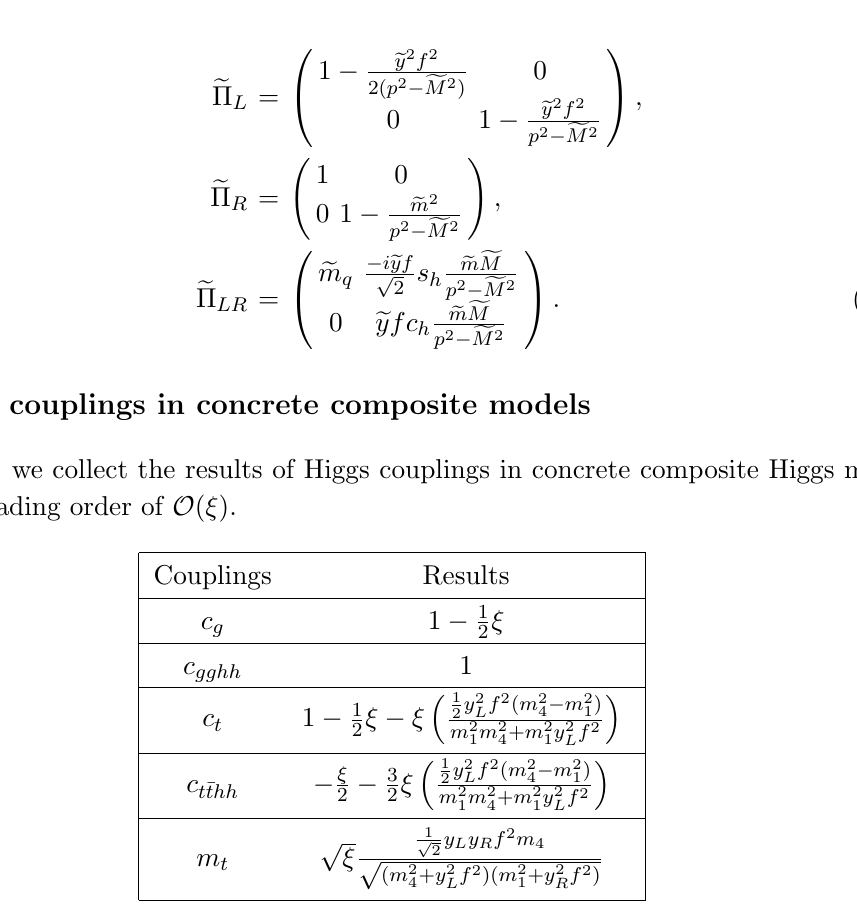
Table 2 . Higgs Couplings and top mass in MCHM of 5 + 1 Representation, which means t L is embedded in the 5 of SO(5) while t R is a singlet.